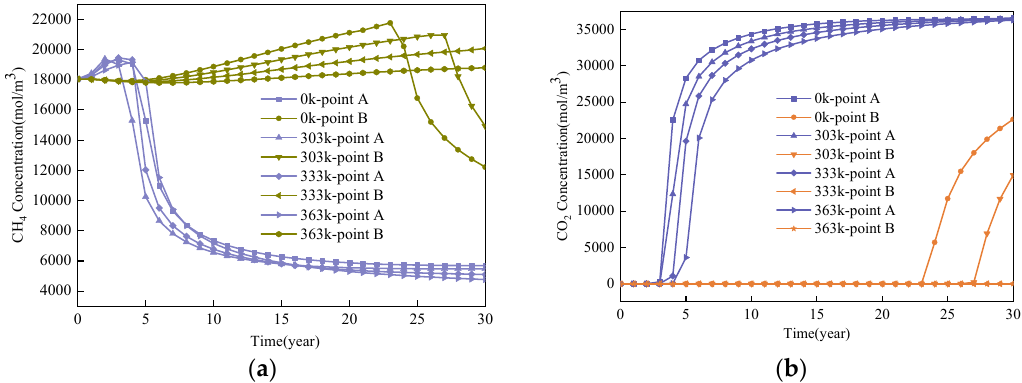
Figure 8. CH 4 and CO 2 molar concentrations at monitoring points A and Bunder different CO 2 injection temperatures: ( a ) CH 4 molar concentration and ( b ) CO 2 molar concentration.